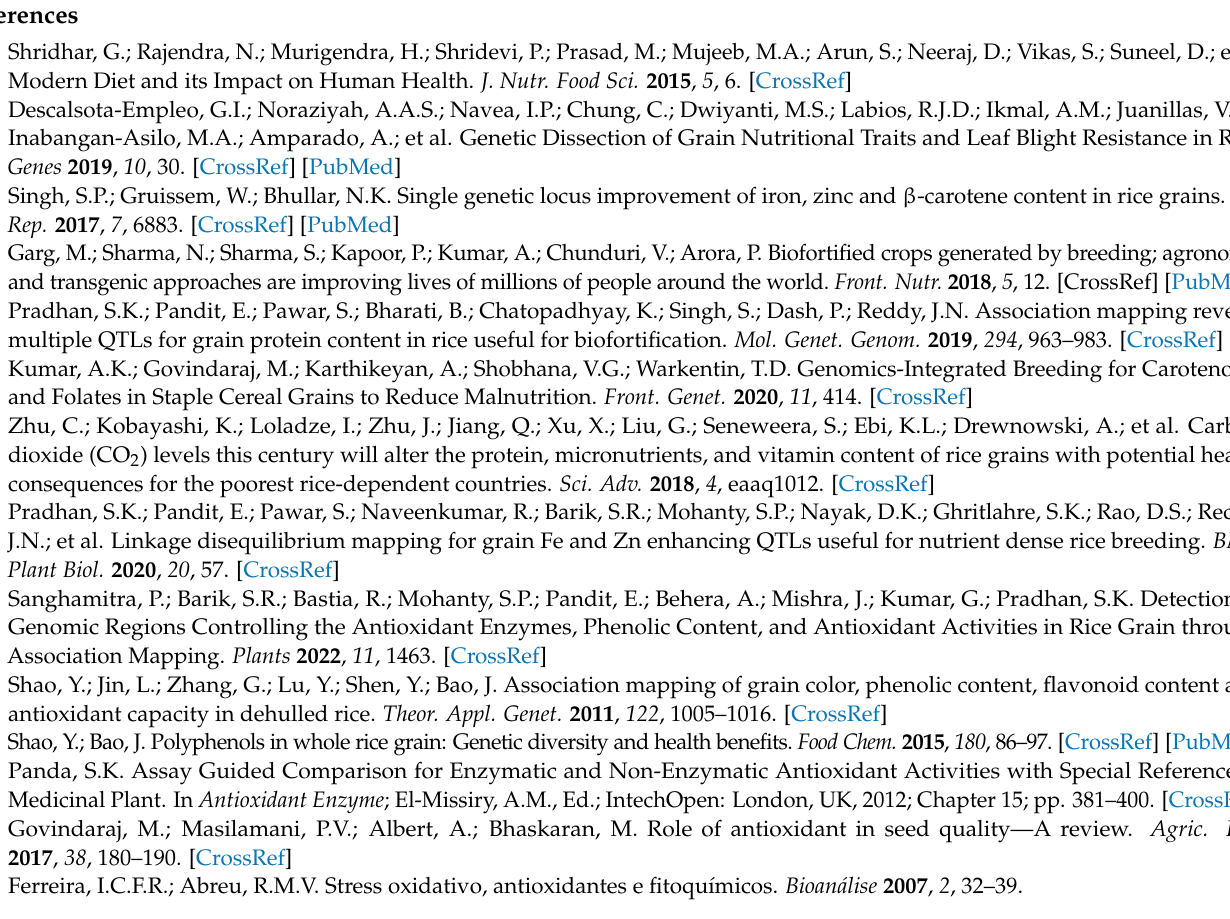
Figure S4: The distributi pattern of alpha value and Fst values in the 4 subpopulations at K = 4. Table S1: Mean values of carotenoids, SOD, TAC, GO, TFC and ABTS antioxidants in 270 rice germplasm line. Table S2: The inferred ancestry value and population structure of individual member with their antioxidants classification in the panel population at K = 2 & K = 3. Table S3: Marker-trait associations with antioxidant content in the panel population detected by the model GLM at p < 0.01. Table S4: Marker-trait associations with antioxidant content in the panel population detected by the model MLM at p < 0.01. Table S5: Markers information of the selected 136 SSR markers used for antioxidant content in indica